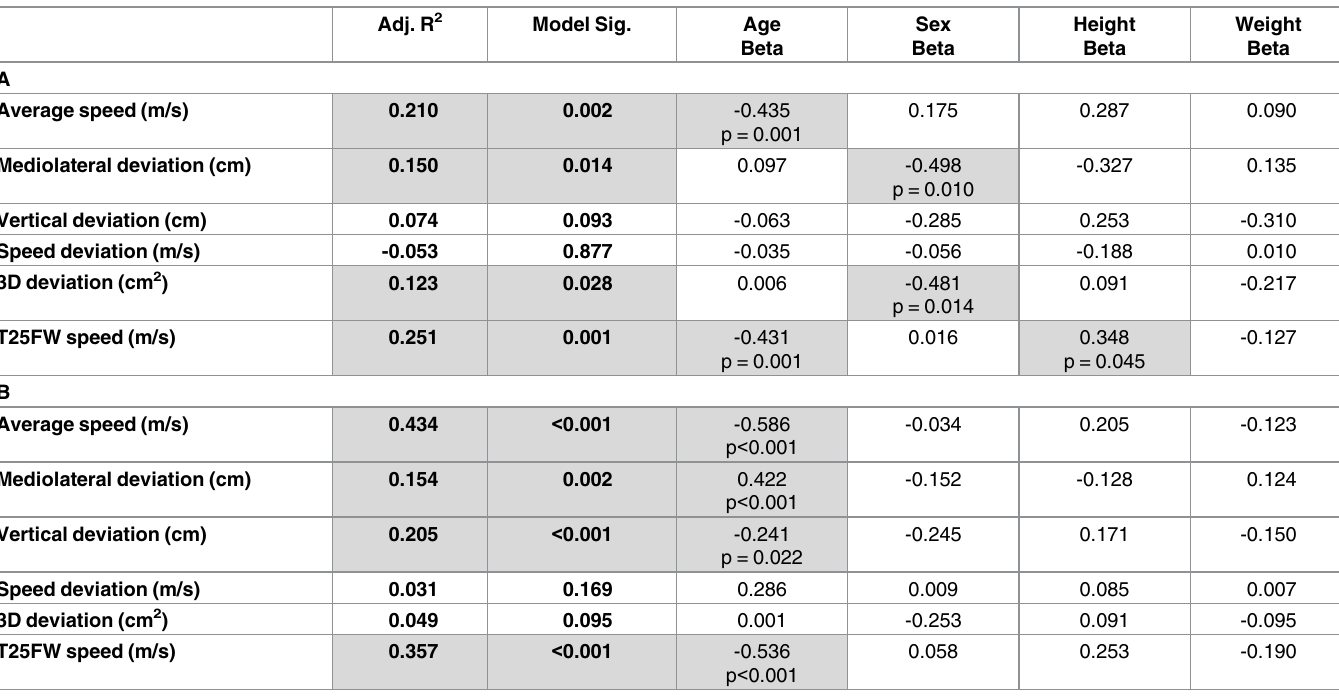
Table 5. Demographic confounders in HC (A) and PwMS